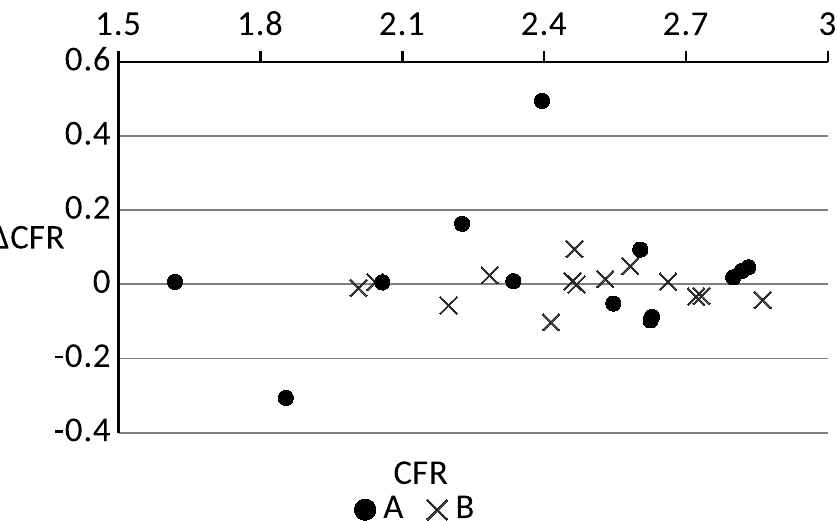
Figure 5. Difference between the CFRs, which were calculated for the full trees and reduced trees (A—terminal points algorithm, B—recursive